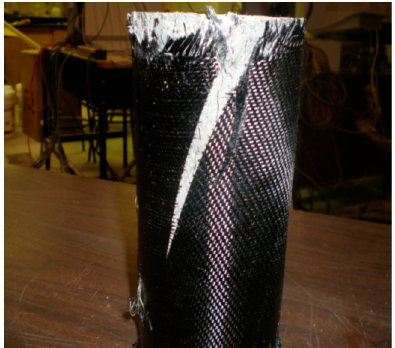
Figure 11. FRP rupture at experimental tests. Elarbi, 2011 [2].